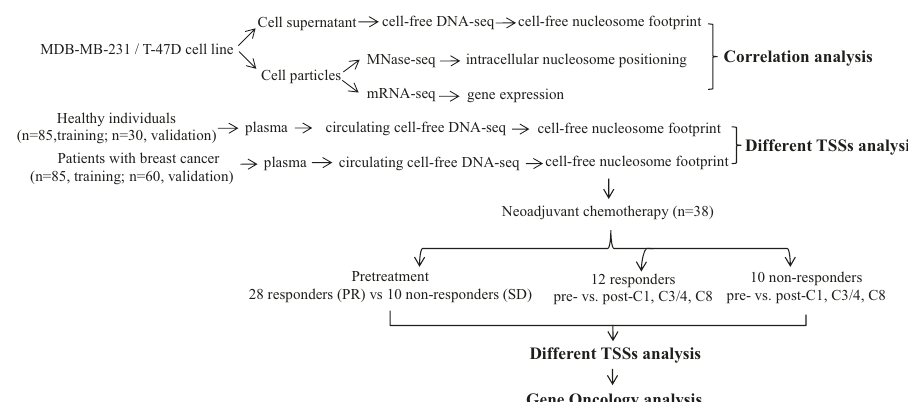
Fig. 1 Experimental design and fl owchart of data analyses. The correlation of cfDNA nucleosome pro fi le, intracellular nucleosome positioning, and gene expression was analyzed by using breast cancer cell lines MDA-MB-231 and T-47D. Next the different nucleosome positioning on cfDNA of breast cancer patients and healthy individuals was analyzed. And fi nally the footprints of cfDNA corresponding with the responses to neoadjuvant chemotherapy in patients at pretreatment and after teatment were identi fi